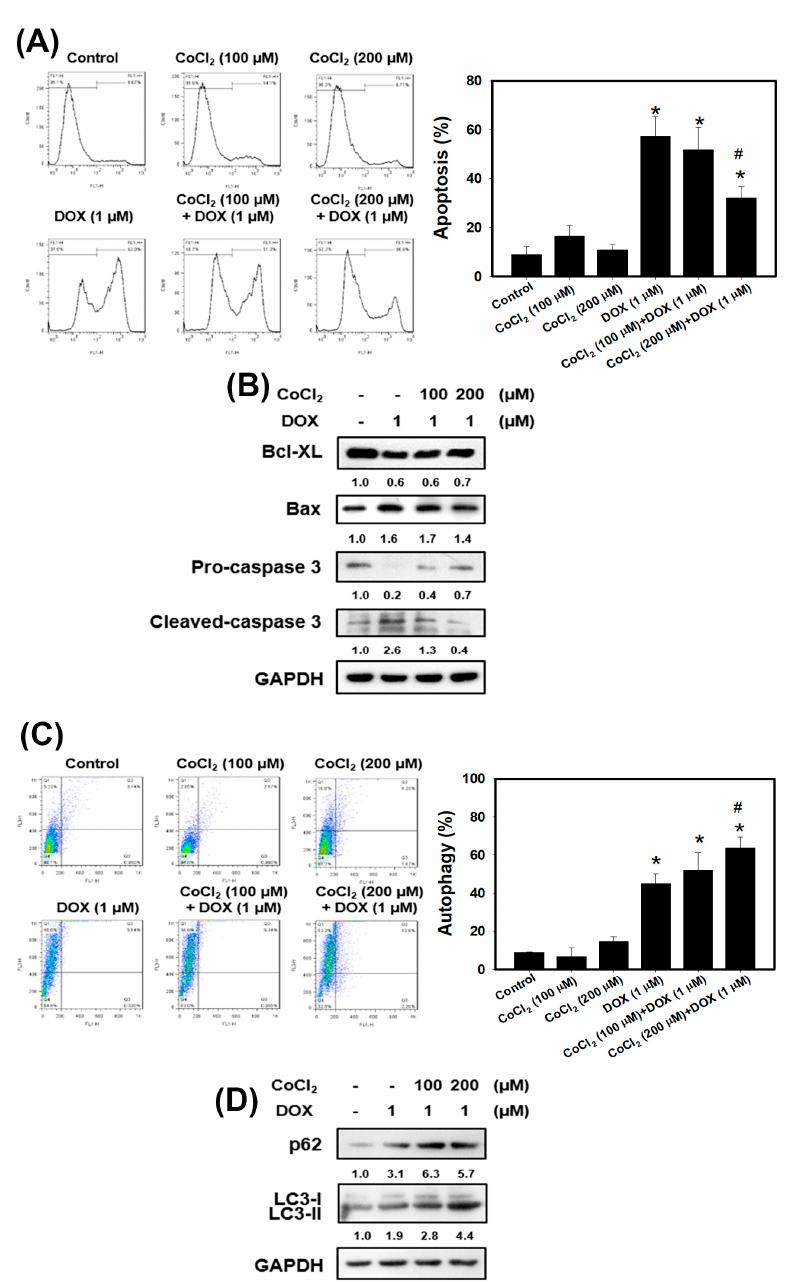
Figure 3. Detection of apoptosis and autophagy in 4T1 cells that received DOX and/or CoCl 2 treatments. ( A ) apoptosis was analyzed by flow cytometry with an Annexin V apoptosis detection kit. 4T1 cells were pretreated with CoCl 2 for 24 h and then treated with DOX for 24 h. * p < 0.05 compared with control. # p < 0.05 DOX alone compared with 200 µ M CoCl 2 + DOX. ( B ) effects of apoptosis-related protein expression in 4T1 cells treated with DOX and CoCl 2 alone or in combination. Cells were pretreated with CoCl 2 for 24 h and then treated with DOX (1 µ M) for 24 h. ( C ) measurement of acidic vesicular organelles (AVOs) in acridine orange (AO)-stained cells using flow cytometry. 4T1 cells were pretreated with CoCl 2 for 24 h and then treated with DOX for 24 h. * p < 0.05 compared with control. # p < 0.05 DOX alone compared with 200 µ M CoCl 2 + DOX. ( D ) effects of